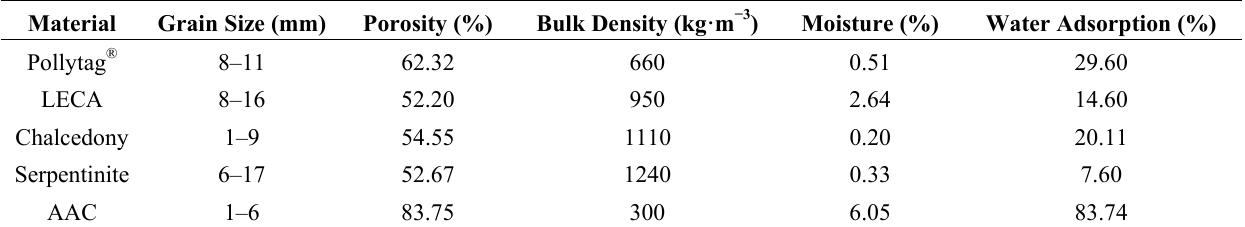
Table 5. Summary table of physical parameters of